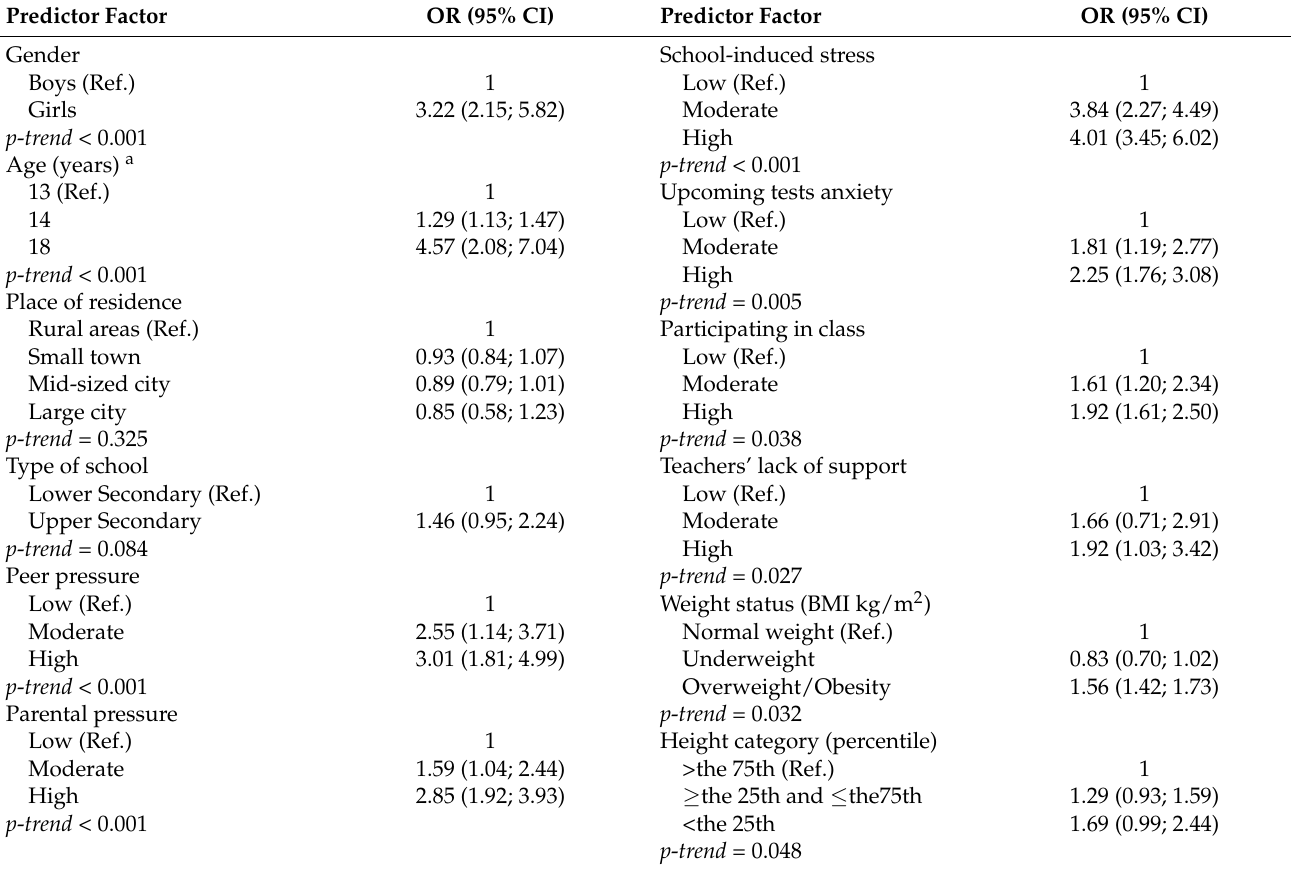
Table 4. Bivariate associations between high level of perceived stress and candidate predictor factors in adolescent study participants: results of logistic regression analysis, unadjusted odds ratio and 95% confidence